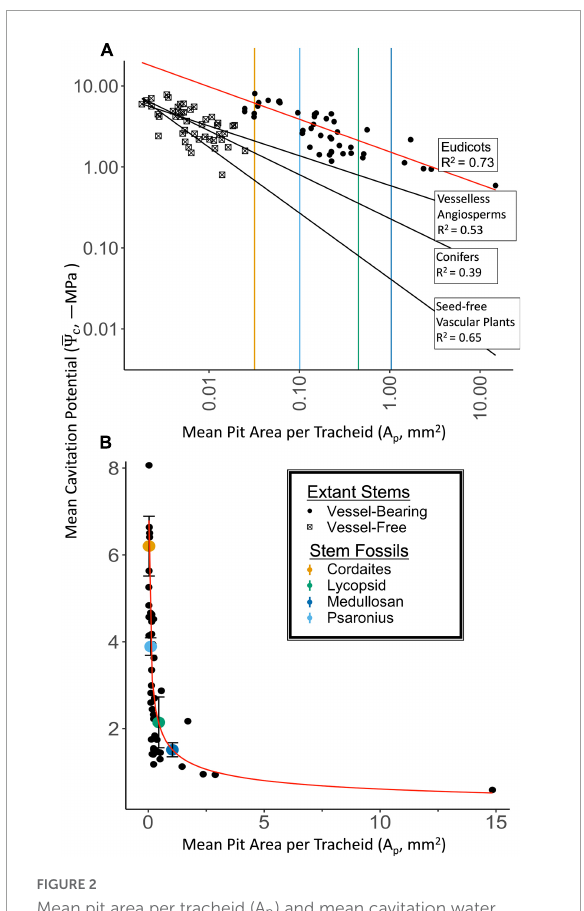
FIGURE2 Mean pit area per tracheid (A p ) and mean cavitation water potential ( ¯ (cid:57) c ) for extinct plants (colored symbols) and extant plants (black symbols; legend applies to both A,B ). (A) Log-log plot of measured A p and mean cavitation water potential ¯ (cid:57) c for extant plants (black symbols: eudicots, vesselless angiosperms, conifers, and seed free vascular plants from Pittermann et al., 2006; Hacke et al., 2007; Brodersen et al., 2014). Power functions fit to each dataset are presented as black lines (vessel-free) and red lines (vessel-bearing; eudicots). Vertical lines represent A P estimated from stem fossils, which are vessel free, but outside the range of A P from extant vessel-free plants (box symbols). Power function intersections with vertical lines represent the possible cavitation potentials that would be predicted based on data for each extant group. The empirical model based on A p for extant eudicots predicts the least vulnerability to cavitation (tolerance of the most extreme water potential). (B) Cartesian plot of the empirical model based on eudicot data (red line; (cid:57) c = –1.538*A p - 0 . 402 ) that was selected for use in downstream simulations due the disjoint ranges, and conservation of plant function. The empirical model used to predict extinct plant (cid:57) c based on measured fossil xylem A p . Mean and standard deviation of simulated empirical distribution for each fossil group are presented as color filled dot and error bars. Fossil xylem A p are calculated based on a mixture of literature and measured values and assumptions regarding their distributions, therefore variability for A p is not